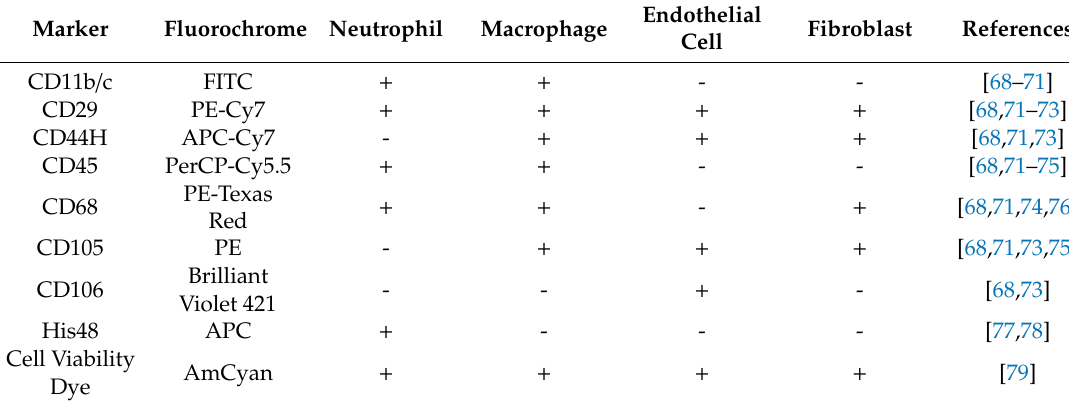
Table 2. Rat cell surface marker profile for flow cytometry in Panel A. “ + ” denotes positive expression and “-” denotes negative expression.